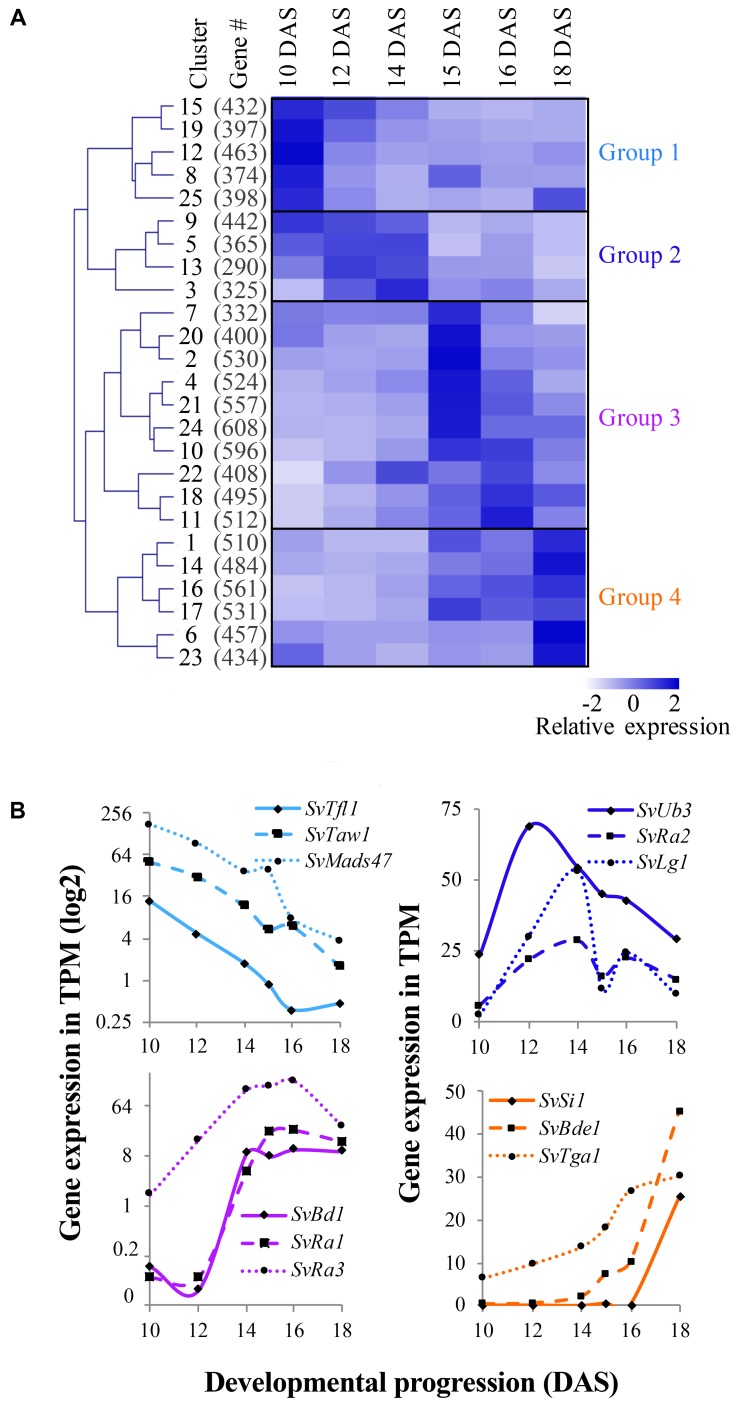
Co-expression analysis revealed distinct gene expression signatures during Setaria viridis inflorescence development. (A) FCM clustering of 11,425 dynamically expressed genes identified 25 co-expression clusters. The mean relative expression value of genes in each cluster across development was used for hierarchical clustering and is displayed by the heatmap. Overall clusters organized into four general groups of expression associated with key developmental transitions. White-to-dark shading represents low-to-high relative expression level. (B) Within each of the four expression groups, homologs of known developmental genes from other species showed expected expression patterns.